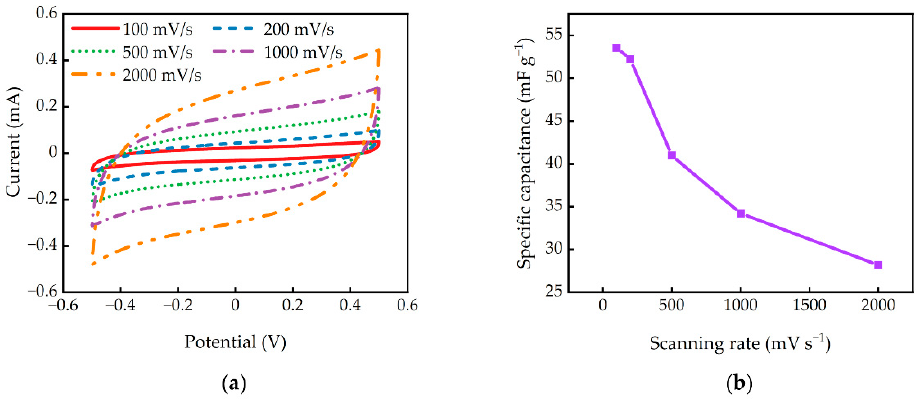
Figure 12. Electrochemical test results at different scanning rates: ( a ) CV; ( b ) gravimetric specific capacitance.